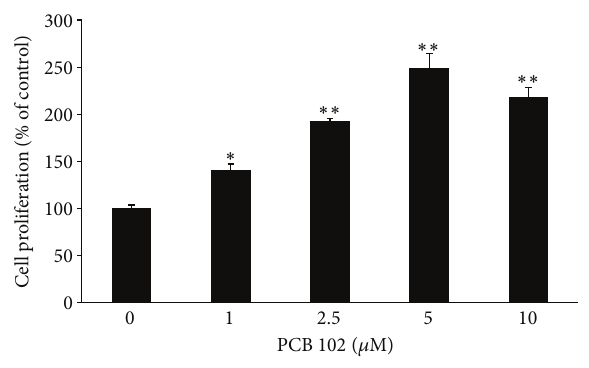
Figure 1: PCB 102 increases MCF-7/BOS breast cancer cell prolif- eration. MCF-7/BOS cells were treated with varying concentrations of PCB 102 (1, 2.5, 5, and 10 𝜇 M) for 72 hours. Cell numbers were determined by hemocytometer and expressed as a percentage of the DMSO control (set at 100%). Values are expressed as mean ± SE ( 𝑛 = 3 ). Significance of differences between means: ∗ 𝑃 < 0.05 , ∗∗ 𝑃 < 0.001 compared to DMSO control.